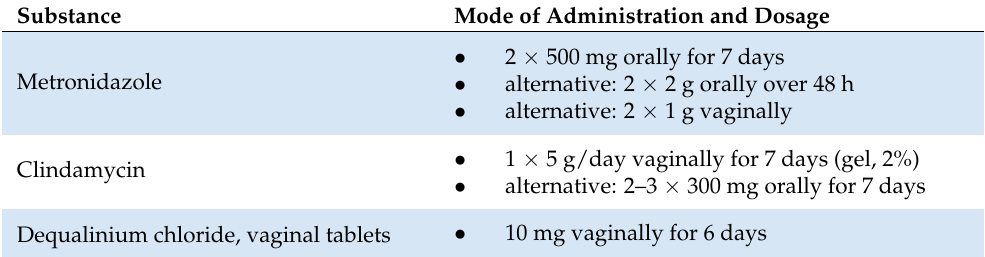
Table 3. Treatment options for bacterial vaginosis